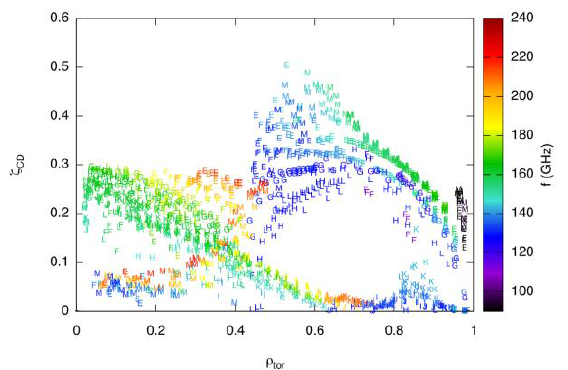
Fig. 3 : A selection of the configurations and their normalised current drive efficiency. Launch points are represented by letters and the colour denotes the launch frequency